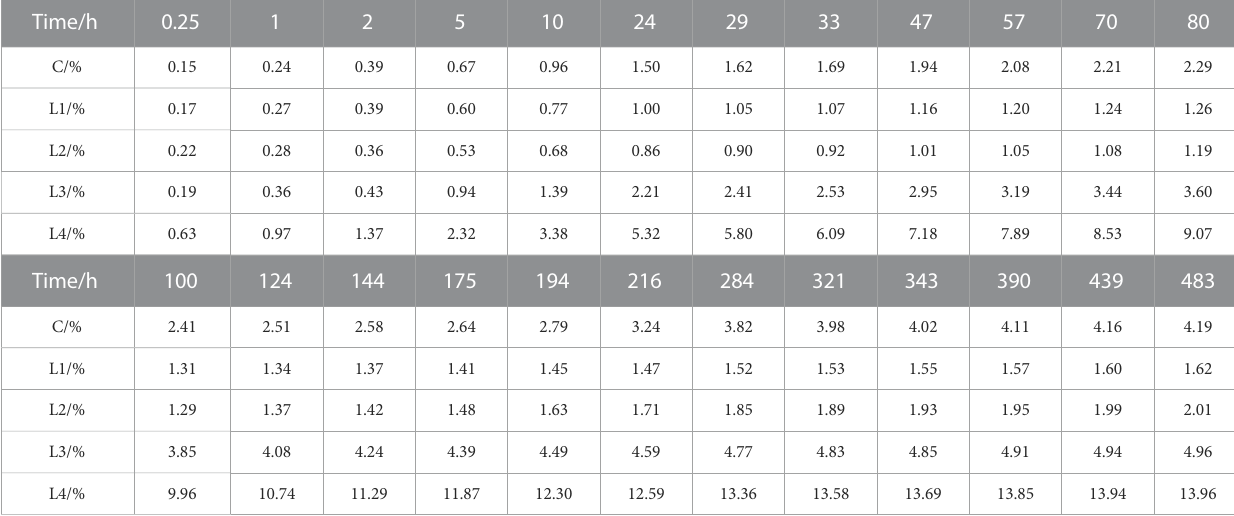
TABLE 3 Water absorption rate of cement – lithium slag mortar at 7 days.